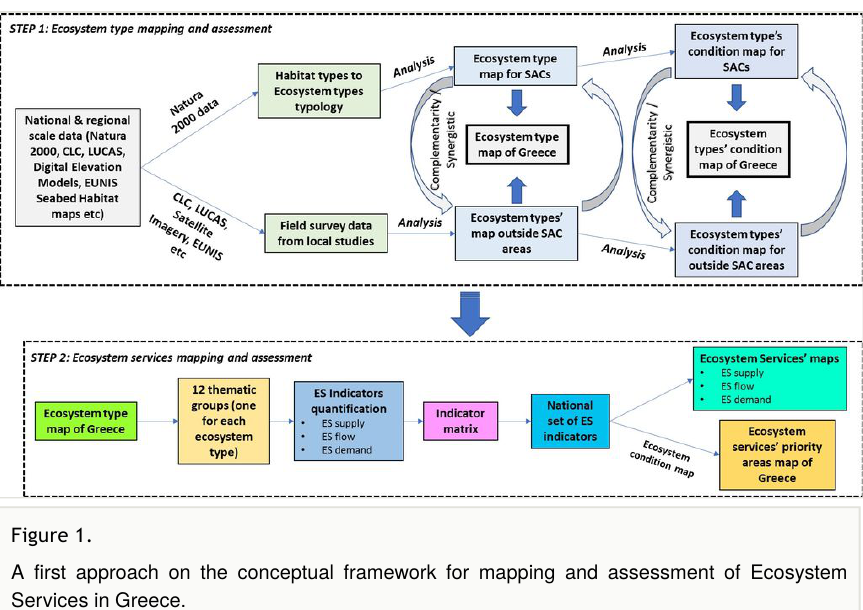
A fi rst approach on the conceptual framework for mapping and assessment of Ecosystem Services in